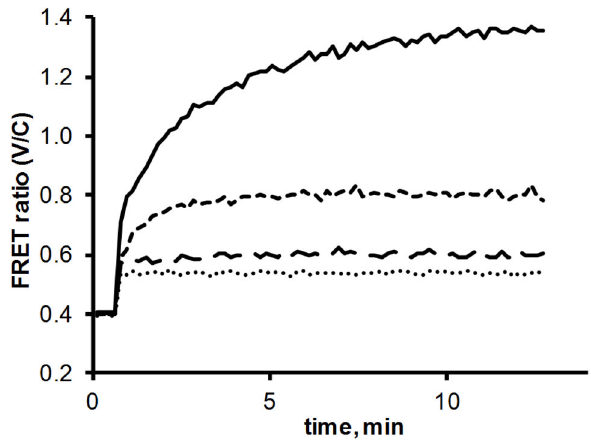
Figure 3. NAGK ‑ FL25 ‑ C interaction with different P - II Venus-mutants: NAGK ‑ FL25 ‑ C was preincubated in the reaction mix at 37 °C for 10 min. The measurement was started by recording the FRET ratio (525 nm / 475 nm emission) every 8 s. After two minutes the different P mutants II were added: P -ST ‑ V (solid line), P -S49G ‑ ST ‑ V (dashed line), II II P -E85A ‑ ST ‑ V (long-dashed line) and P -S49G ‑ E85A ‑ ST ‑ V II II (dotted